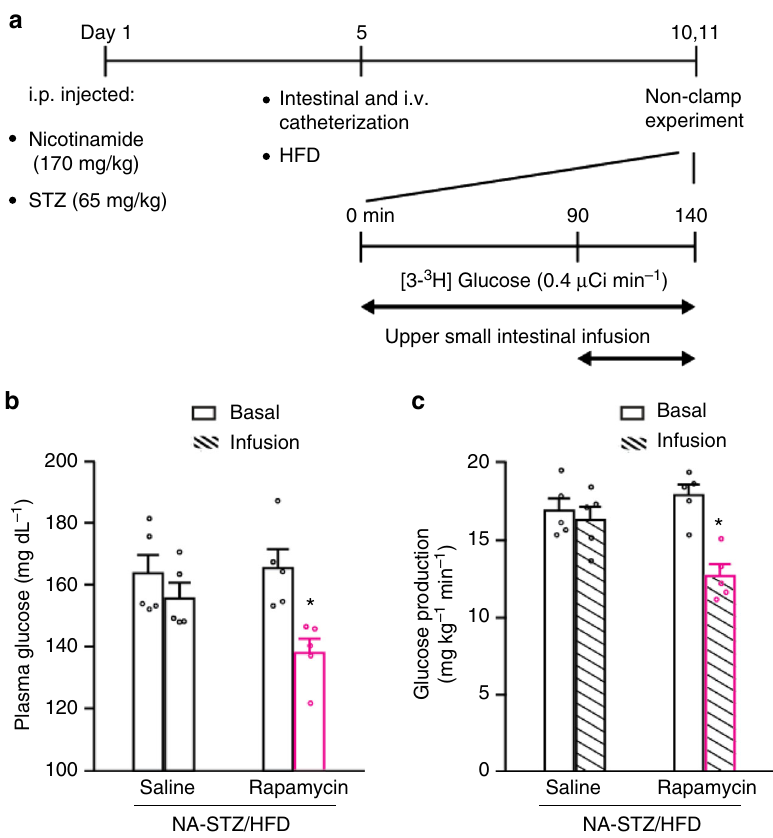
Fig. 5 Inhibition of upper small intestinal mTOR lowers glucose in diabetic rats. a Experimental procedure and non-clamp experimental protocol. b , c Plasma glucose levels ( b ) and glucose production ( c ) in NA – STZ/HFD-induced hyperglycemic rats infused with upper small intestinal saline or rapamycin. * p < 0.05 vs. saline as compared by unpaired t -test; n = 5 for each group. Values are shown as mean ±